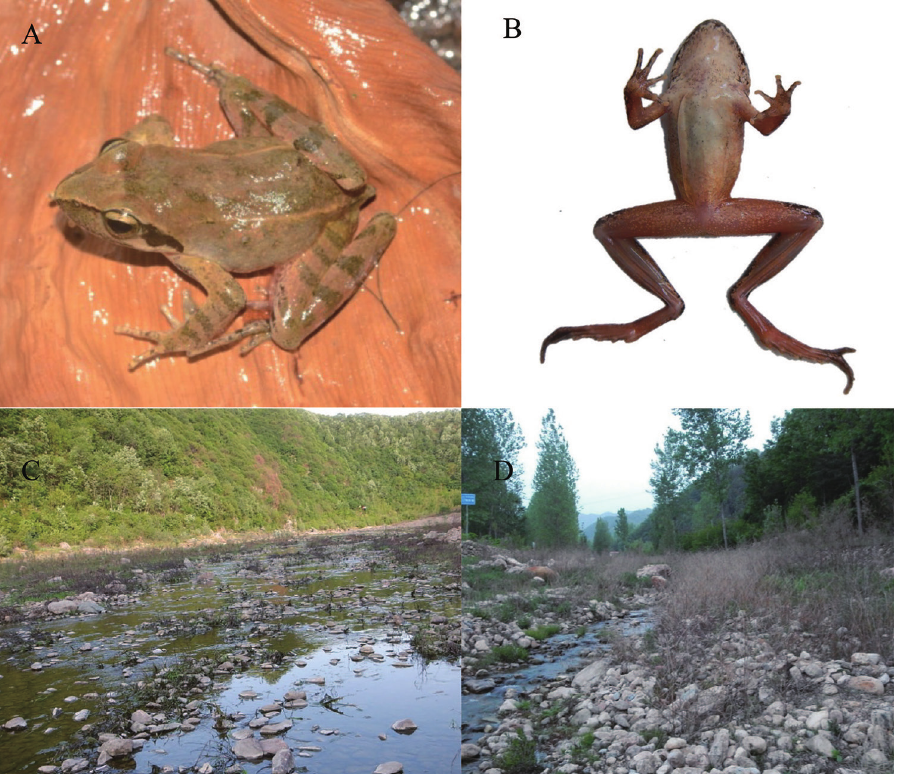
Figure 3. Photographs of a live specimen and its habitat near the type locality of Rana luanchuanensis sp. n. A Lateral view B Ventral view C, D Habitat of the type locality of R. luanchuanensis showing a live